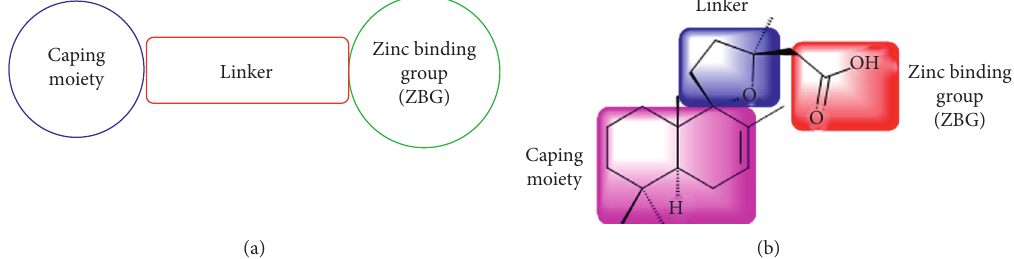
Figure 2: (a) Essential pharmacophoric features of HDAC inhibitors. (b) Essential pharmacophoric features of grindelic acid against HDAC.